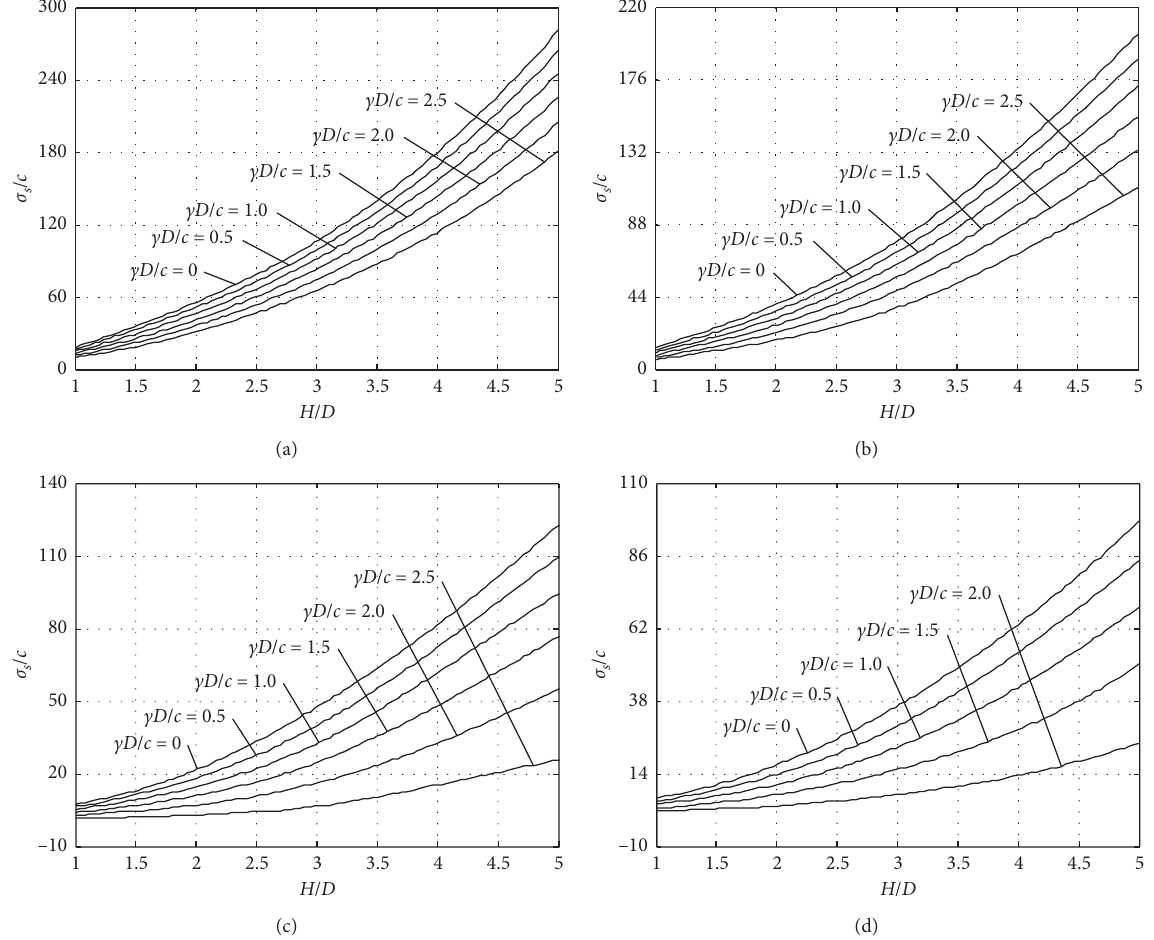
Figure 3: Stability numbers for rectangular tunnels ( φ � 30 ° ). (a) B / D � 0.5. (b) B / D � 0.75. (c) B / D � 1.25. (d) B / D �